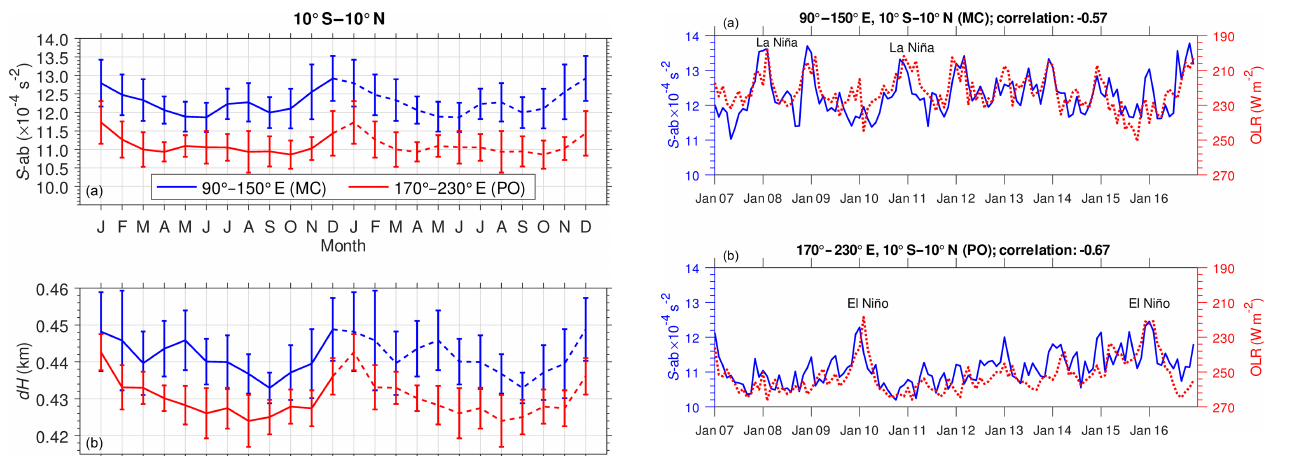
Figure 9. Time series of monthly mean S -ab (solid blue line) and OLR (dotted red line) for the MC (a) and PO (b)